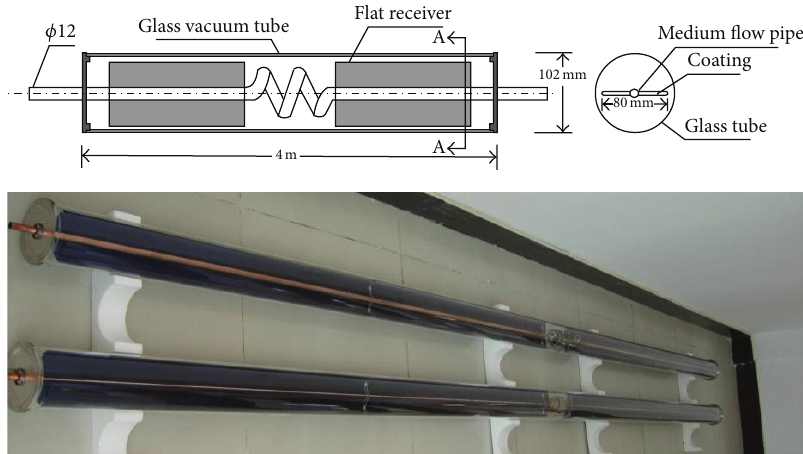
Figure 2: Structure and photo of the evacuated-tube finned plate solar